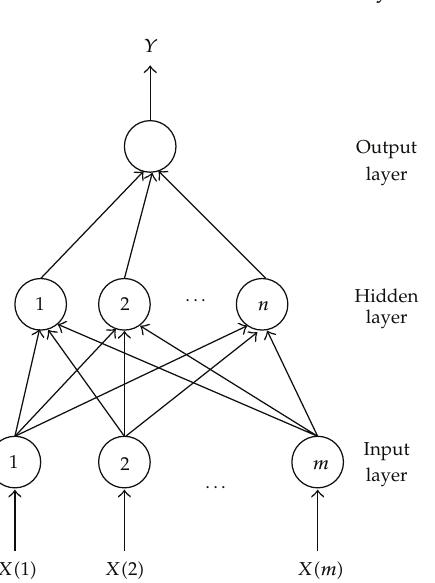
Figure 1: Chaos neural network base